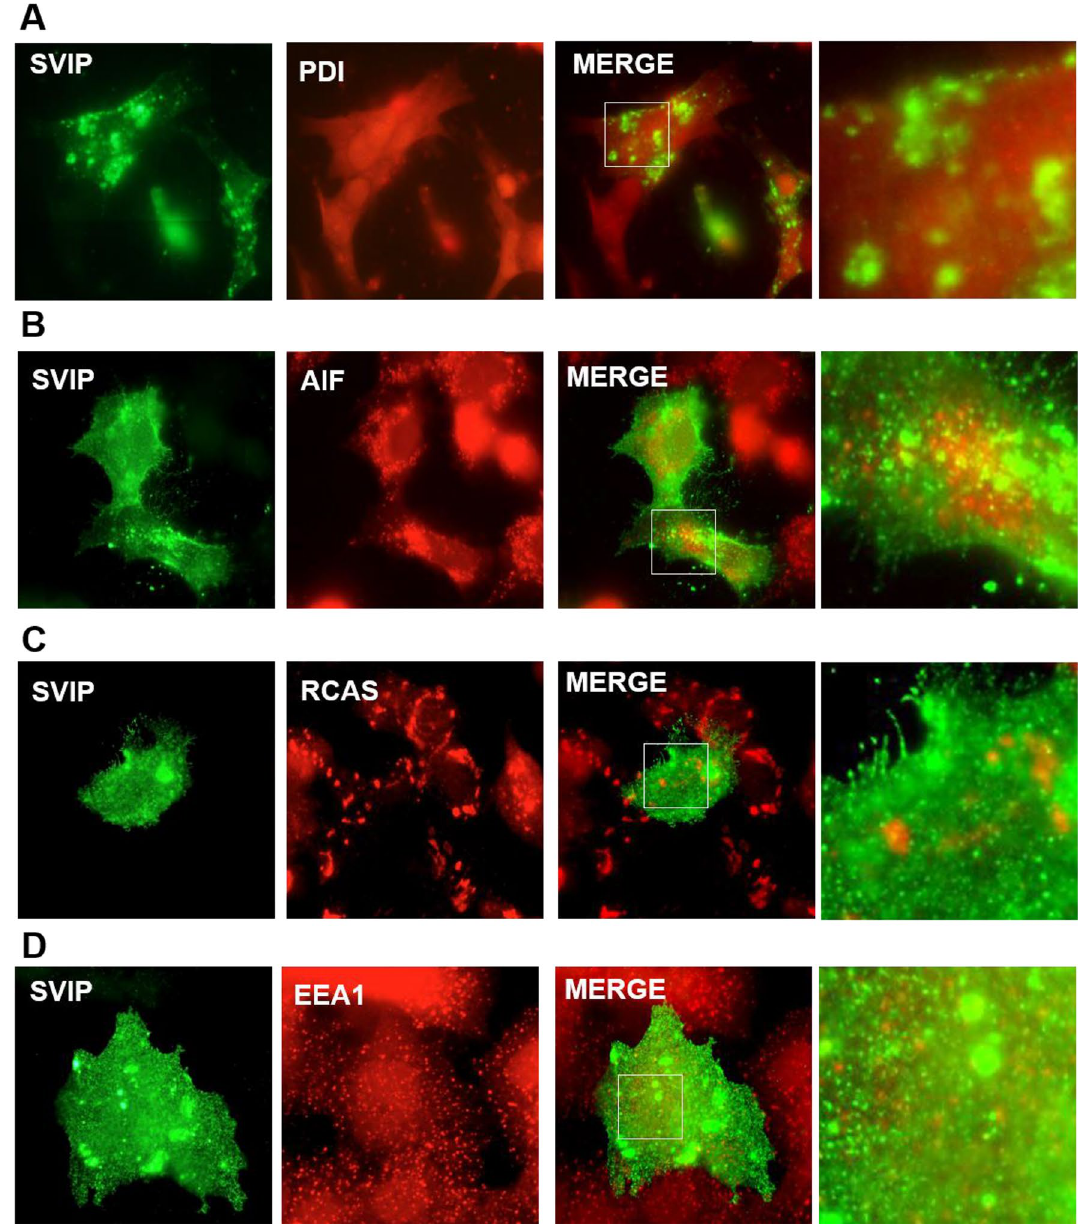
Figure 4. SVIP is co-localized with lysosomes and p97/VCP. H295R cells were transfected with 0.5 μg pCIneo- SVIP-His plasmid, then cells were co-stained with anti-His antibody and specific antibodies against organelle markers: ( A ) PDI (ER marker), ( B ) AIF (mitochondria marker), ( C ) RCAS (Golgi marker), ( D ) EEA1 (early endosomes marker), and ( E ) LAMP1 (lysosomal marker). ( F ) SVIP overexpressed cells were treated with 0.1 μM angiotensin II or 10 μM forskolin for 24 h and double immunostaining of SVIP and LAMP1 was performed. ( G ) SVIP relocalized p97/VCP. Images were taken after double immunostaining with anti-His antibody for SVIP and anti-VCP antibody for endogenous